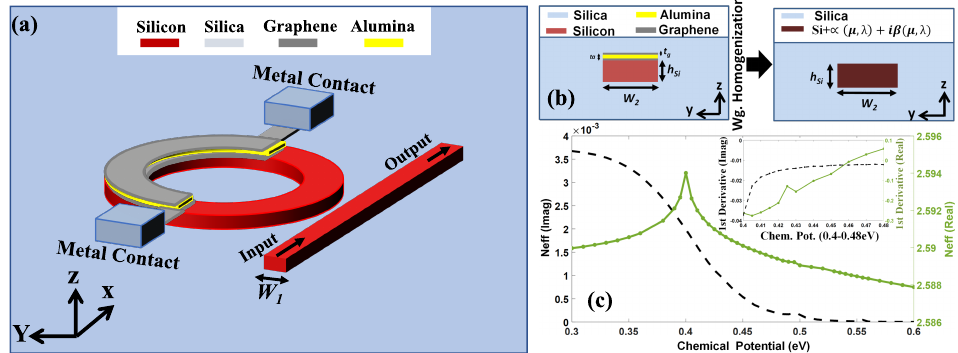
Figure 3. ( a ) Schematic representation of the homogenization approximation technique for the resonator waveguide. ( b ) Real (green) and imaginary (black) part of an effective index for the graphene modulator. Inset: first derivative of real (green) and imaginary (black) parts of refractive index for 0.4–0.48 eV. ( c ) Front view of a graphene ring-resonator coupled with a bus